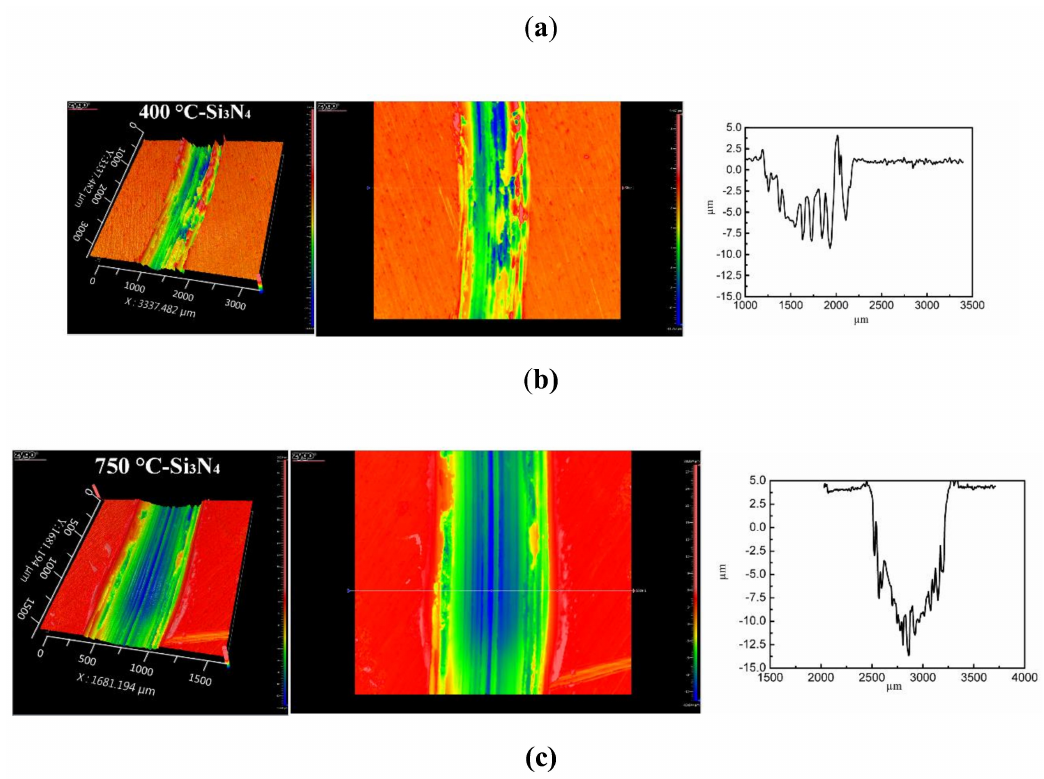
Figure 7. 3D images and profiles of the worn surfaces of the Ti-22Al-25Nb alloy vs. Si 3 N 4 at